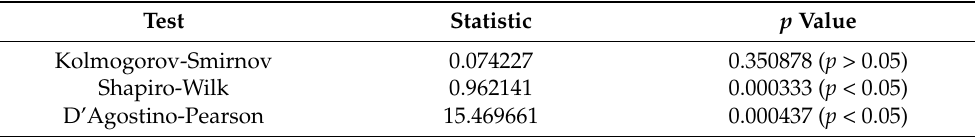
Table 1. Statistical tests for normality (left side of arch support frame).